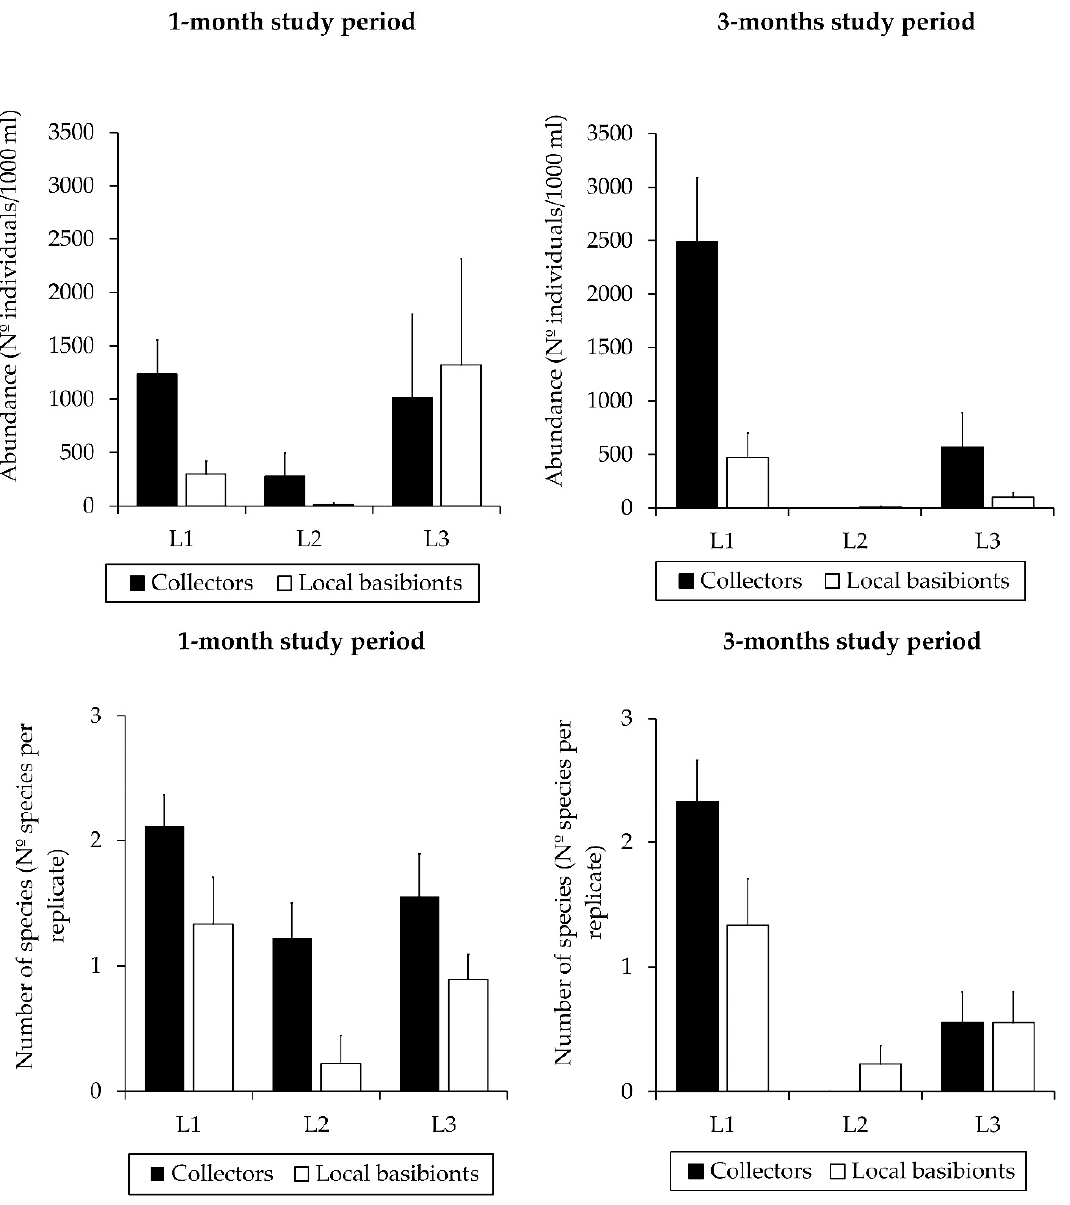
Figure 3. Total abundances of caprellids (mean individuals/1000 mL ± standard error; n = 9) in collectors and local basibionts in each locality surveyed (L1: Sancti Petri marina, L2: Rota marina, L3: Puerto América marina) after one and three months. Number of species per replicate (mean ± standard error; n = 9) in collectors and local basibionts in each locality surveyed after one and three months. Significant differences ( p < 0.05) were detected among the three localities (see Table 1 for details of the Student–Newman–Keul (SNK) tests).